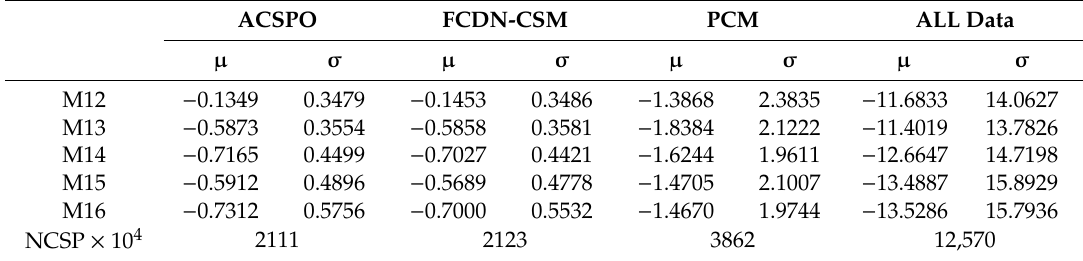
Figure 4. Histograms of VIIRS M12 O-M biases for the cases of PCM, ACSPO, FCDN-CSM, and all data on 11 March 2019. The Y values stand for the ratios between the number of samples in a bin with total number. Table 2. Global O-M statistics for S-NPP on 11 March 2019. ( µ stands for O-M bias and σ is standard deviation).